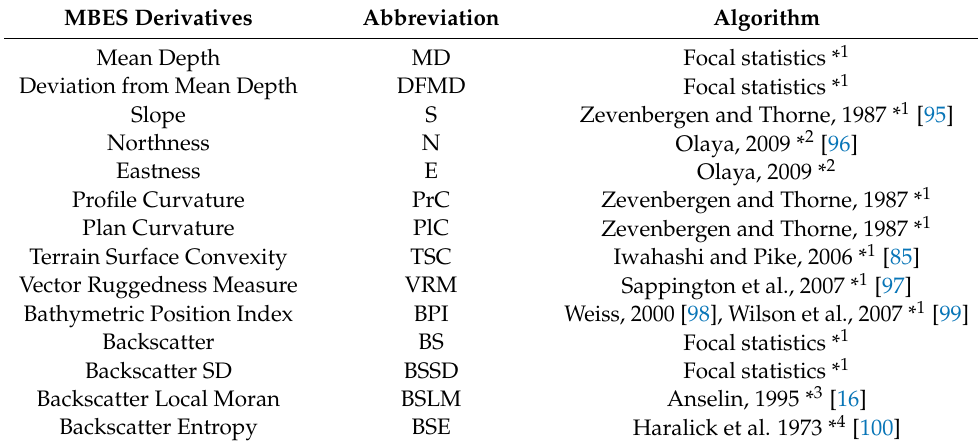
Table 1. MBES derivatives, their abbreviations, and references to their calculation